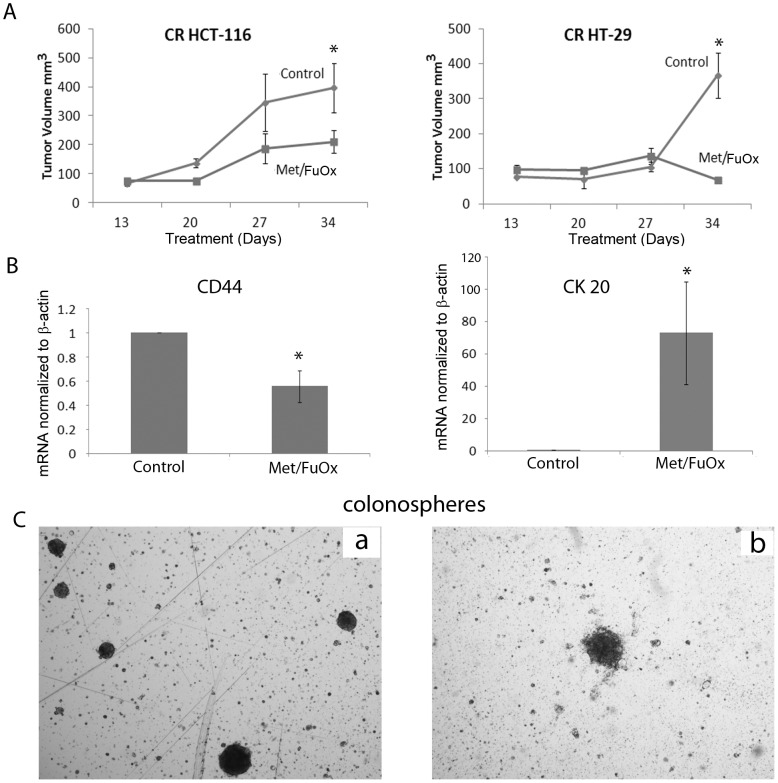
Tumor growth in metformin/FuOx treated SCID mice injected with CR HCT-116 (left pane) or CR HT-29 cells (right panel) (A).Bars represent mean ± standard error. * p >0.05. Real time quantitative PCR on RNA extracted from cells isolated from the CR HT-29 tumor (B). CD44 levels decreased and CK20 levels increased in metformin/FuOx treated xenografts. Colonosphere formation in the cells isolated from CR-HT-29 xenografts (C).